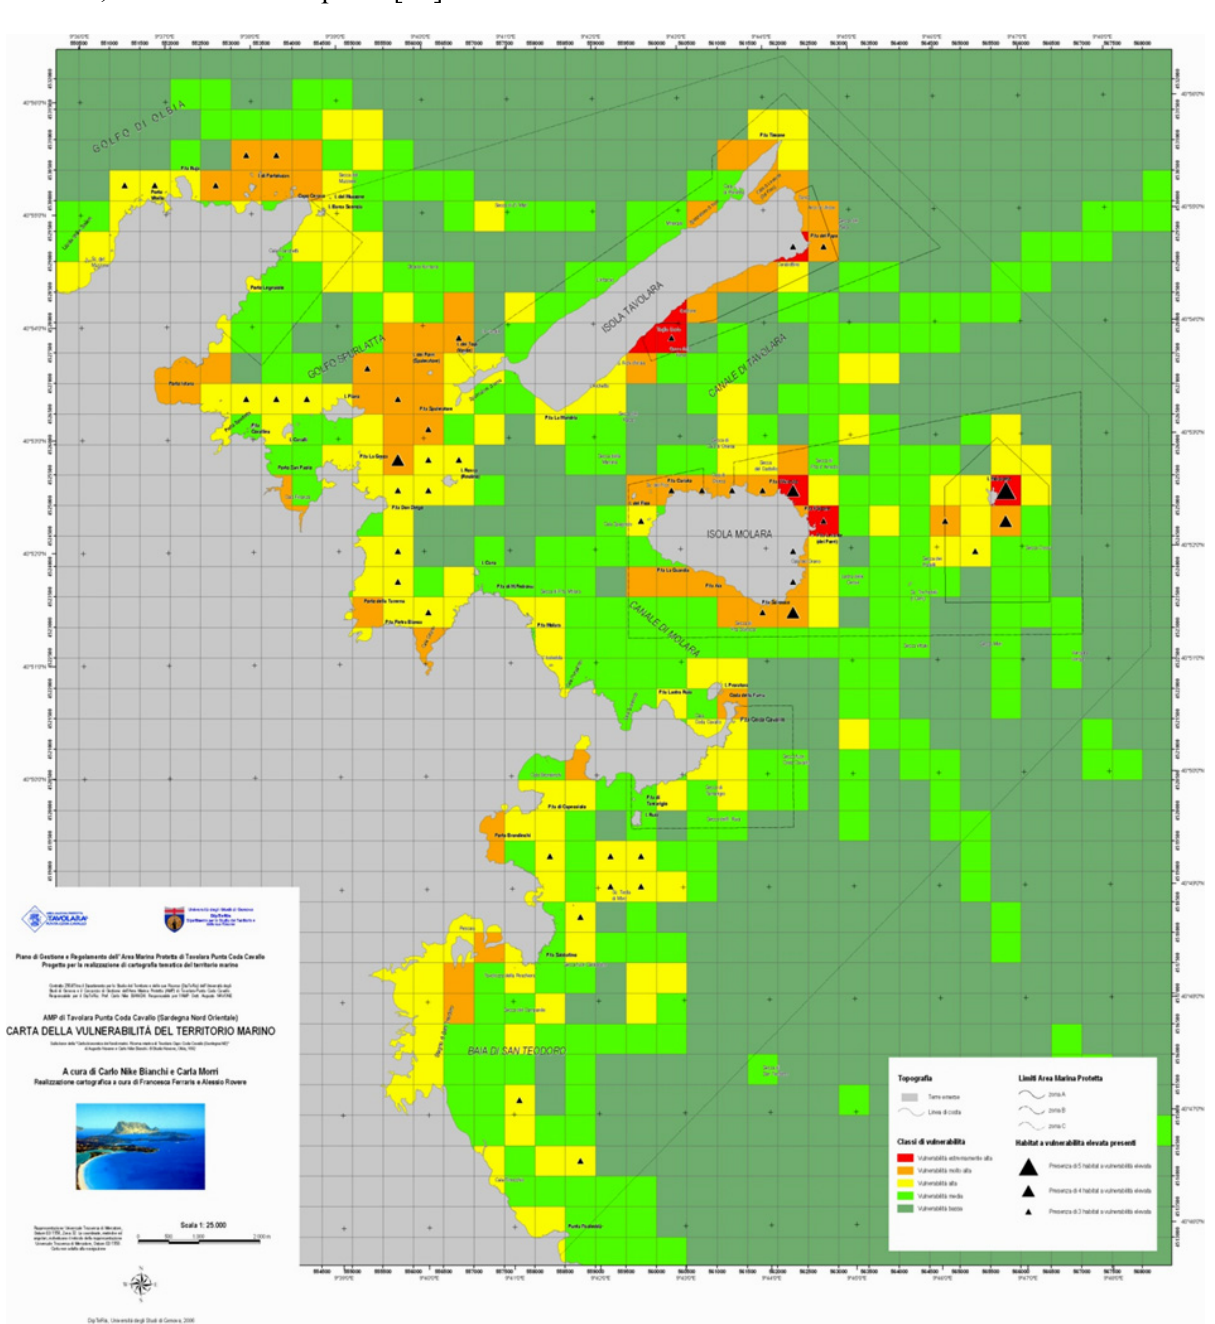
Figure 7. Reproduction at reduced scale of a map of the weighted vulnerability of the marine territory. The example illustrates the MPA “Tavolara–Punta Coda Cavallo” (original scale 1:25,000). This and similar maps can be freely downloaded, at their full size, from the SEAMap site